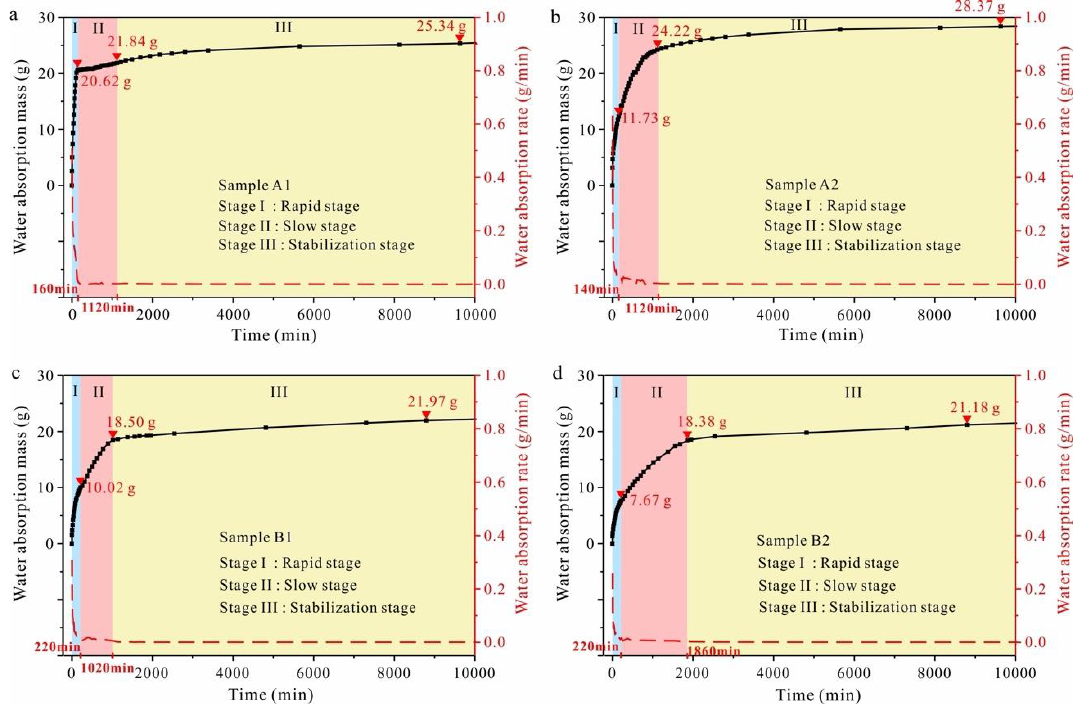
Figure 2. Water-absorption mass vs. time in ( a ) Sample A1; ( b ) Sample A2; ( c ) Sample B1 and ( d ) Sample B2. Table 3. Water-absorption time and mass of samples at each stage.